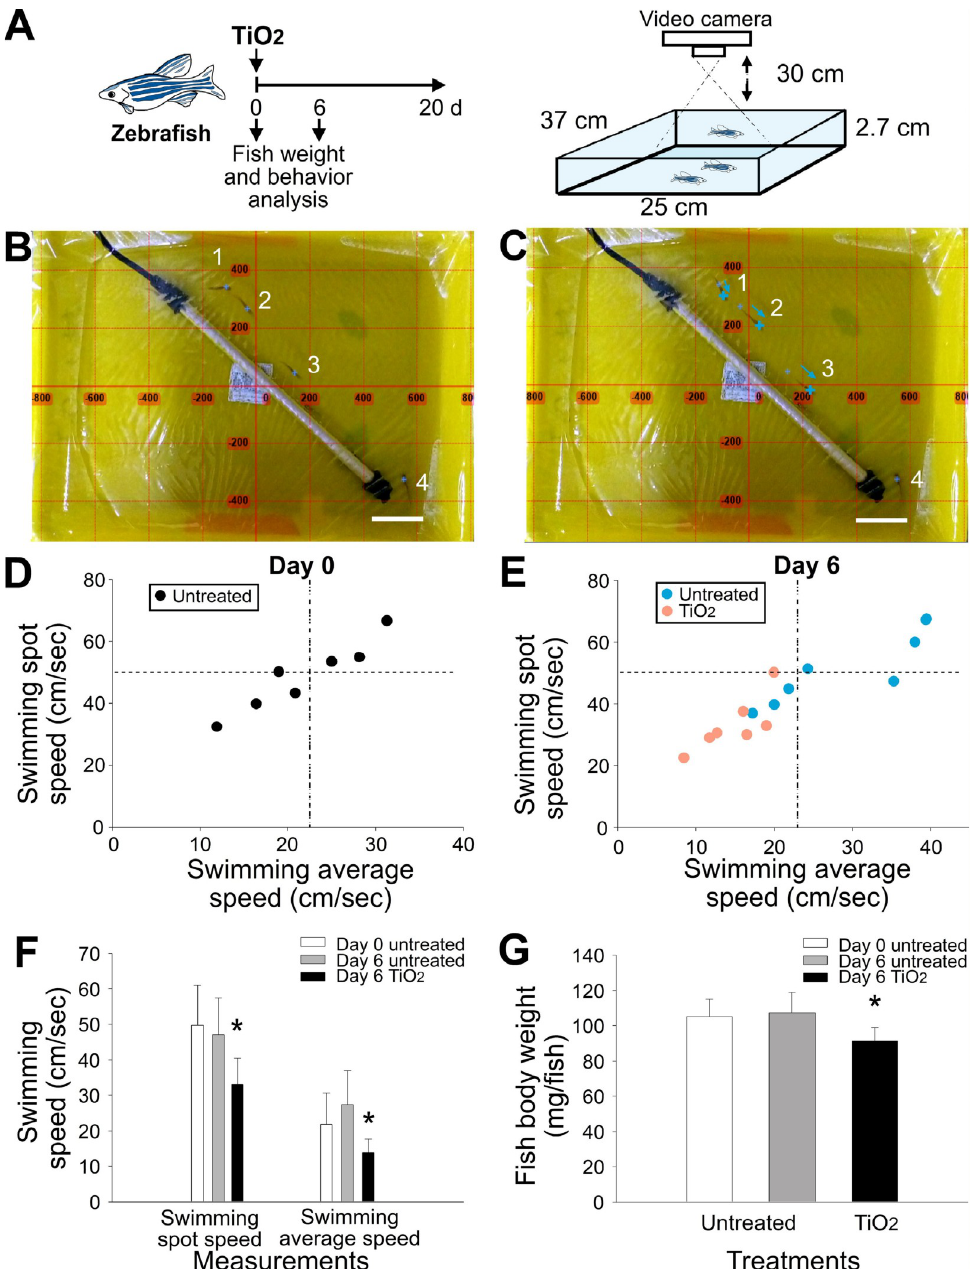
Fig 2. Analysis of zebrafish motility in water containing TiO 2 NPs. (A) Experiment outline and settings. (B, C) Sequential images of zebrafish in tanks with water containing TiO 2 NPs. (D) 2D plots of zebrafish spot swimming speed versus average swimming speed at day 0 (untreated) and (E) day 6 (with or without TiO 2 NPs); dashed lines represent the average spot speed and average swimming speed of the groups at day 0. (F) Statistical analysis of zebrafish swimming speed and (G) body weight under various conditions. � P < 0.05, compared with the untreated groups at day 6. n = 7. pathogenic microorganisms coexist in the normal habitats of wild aquatic life-forms, TiO may theoretically be more toxic to wild fish and lead to higher mortality. As an increasing amount of NPs are released into rivers, lakes, and oceans [65, 66], infections in wild fish and